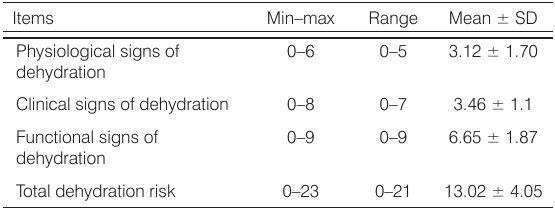
Table 4. The distribution of dehydration appraisal checklist ( N = 305).